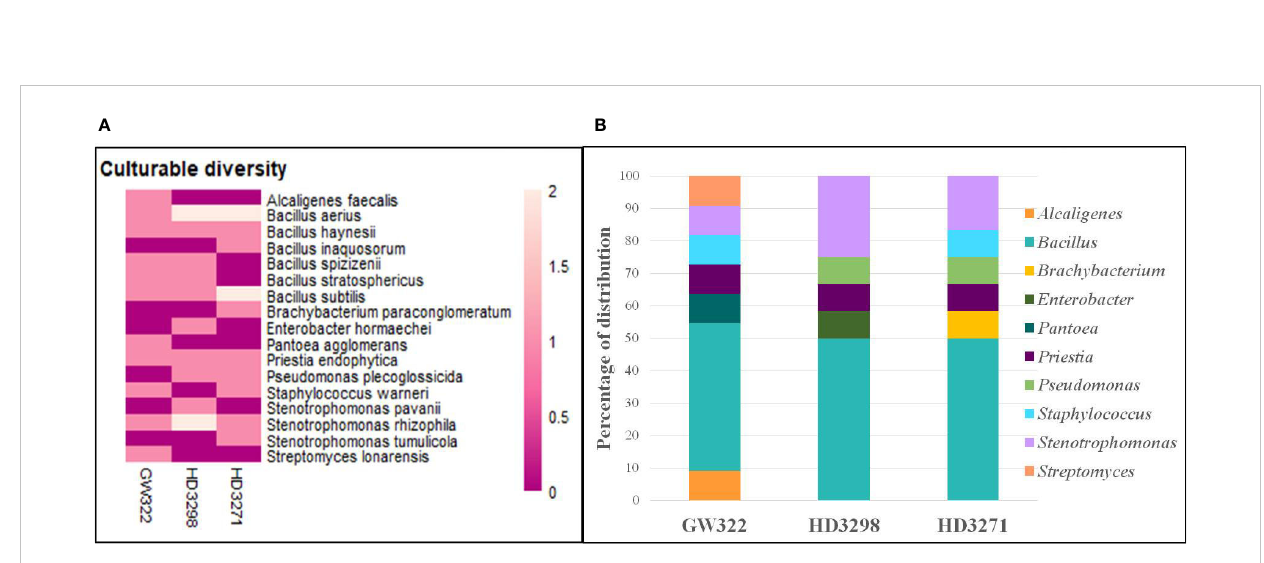
FIGURE 4 Abundance and diversity of WSEB isolates from wheat varieties — heat S (GW322) and heat T (HD3298 and HD3271). (A) Heatmap representing the abundance of culturable bacterial diversity (species level). (B) Relative genera abundance (%) of identi fi ed WSEB isolates.